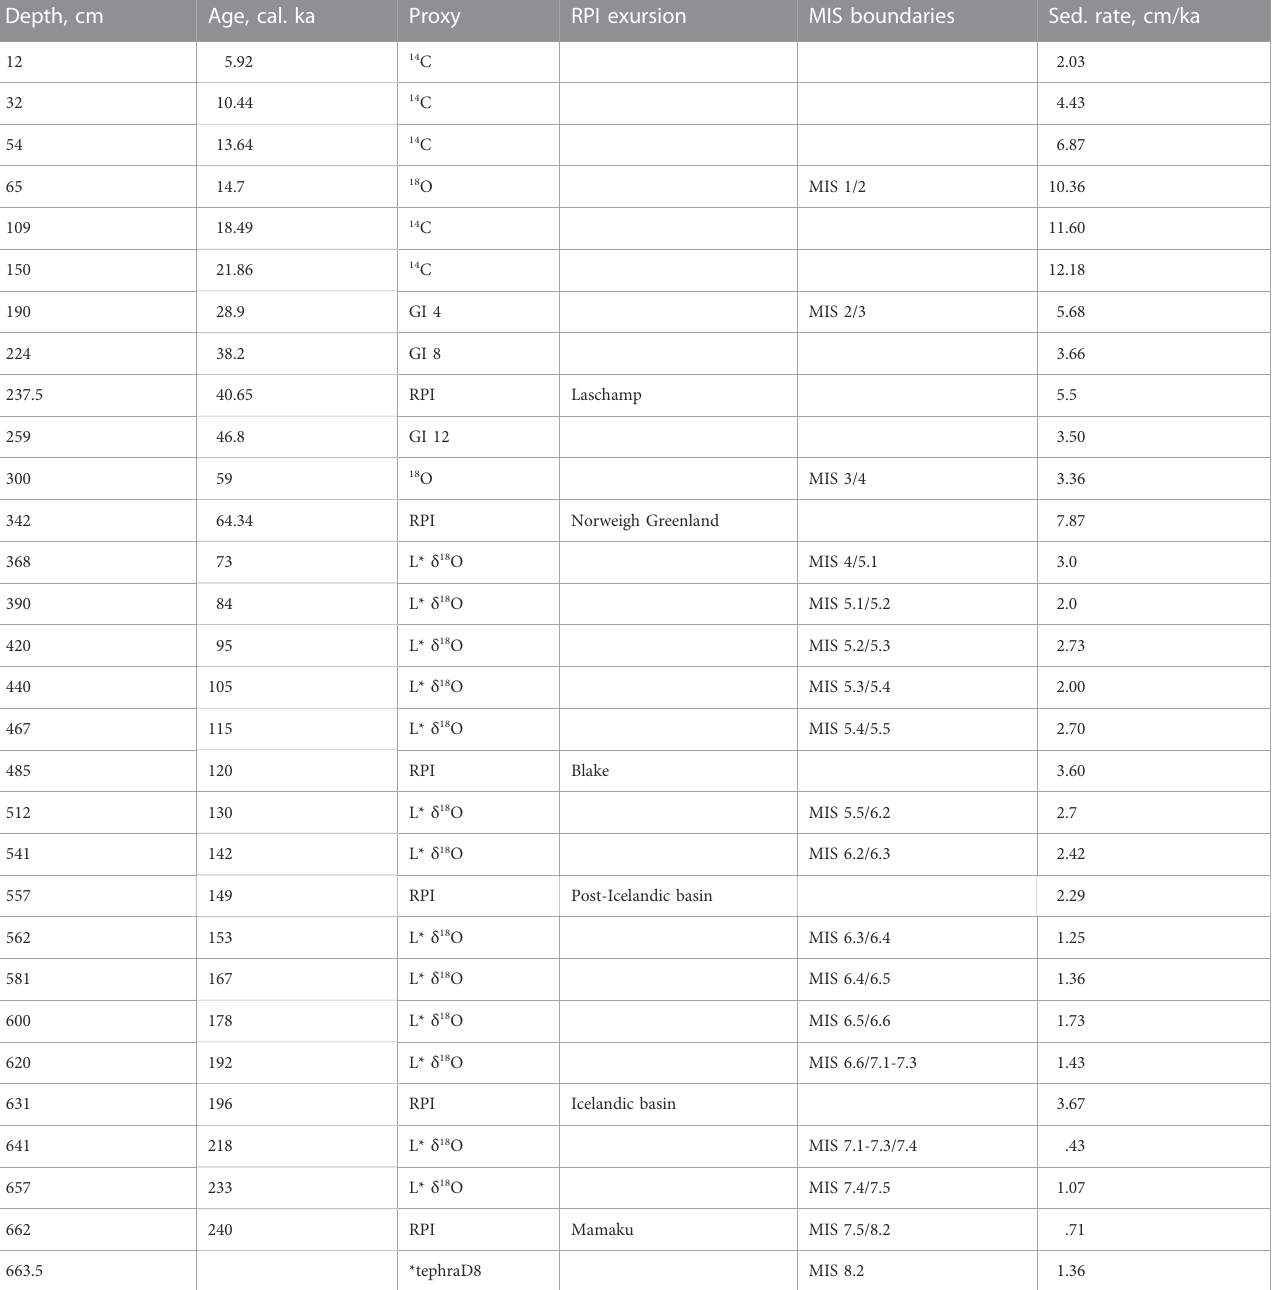
TABLE 1 Age-depth of key time points of core LV63-4-2 and linear sedimentation rate. Depth, cm Age, cal.